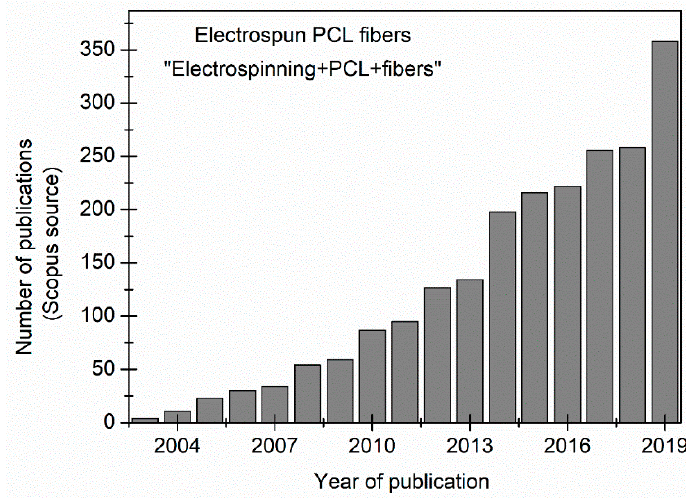
Figure 1. Number of publications on electrospun poly( ε -caprolactone) (PCL) fibers in the last 20 years (Scopus source).